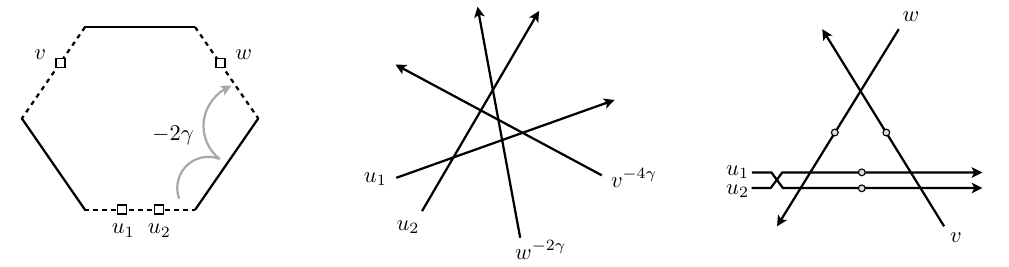
Figure 4 . A generic hexagon form factor. The magnons are distributed on the three mirror edges as in the leftmost panel. In the middle panel, we have the standard representation of the matrix part, obtained by analytically continuing rapidities to the crossed and doubly crossed kinematics. In the rightmost panel, we show an alternative representation where all rapidities are set back to the same kinematics using the crossing properties of h and . This operation (cid:13)ips the orientation S of the w lines and makes the cyclic symmetry manifest. The price to pay for this re-organisation is a grading of the sums over intermediate states in the loops, represented by the